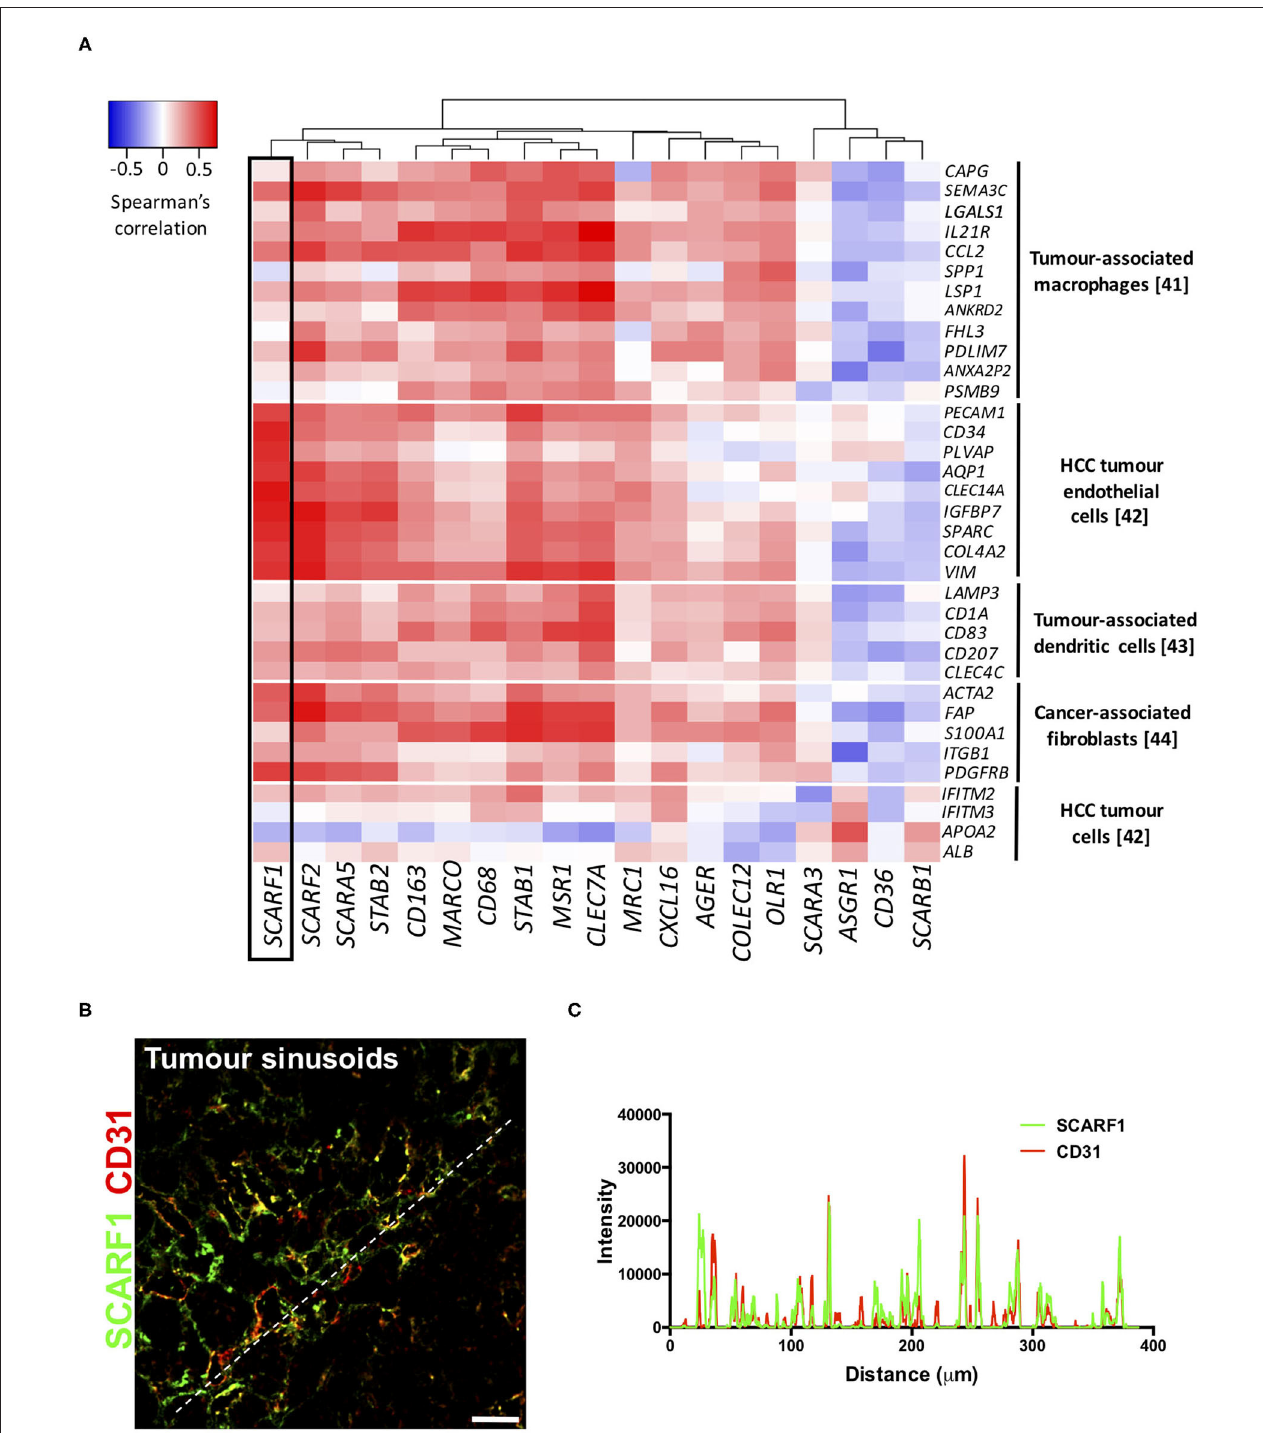
FIGURE 4 | SCARF1 is expressed in HCC tumor endothelial cells. (A) Correlation of scavenger receptor gene expression with tumor-associated cell-specific markers. This analysis was performed via the cBioPortal website (https://www.cbioportal.org/) (accessed 10th August 2020). n = 358. The heatmap was generated with use of the Heatmapper website (http://www.heatmapper.ca/). The black box highlights the expression profile of SCARF1 . (B) Representative image of dual color immunofluorescent staining of SCARF1 (green) and CD31 (red) within HCC tumor sinusoids. Scale bar = 40 µ m. White dashed line delineates site of intensity measurements. (C) Intensity measurements of immunofluorescent staining shown in (B) .